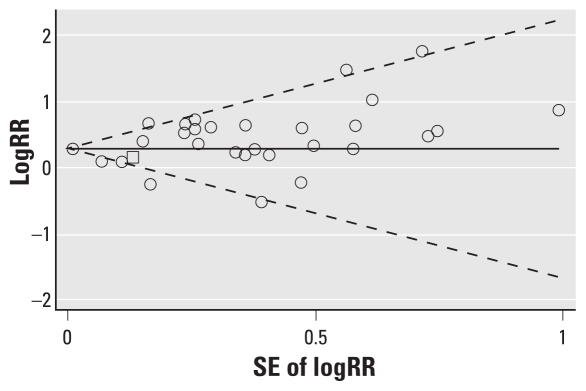
Begg’s funnel plot with pseudo-95% CIs to assess publication bias in case–control studies of lung cancer among persons reoporting occupation as a painter.